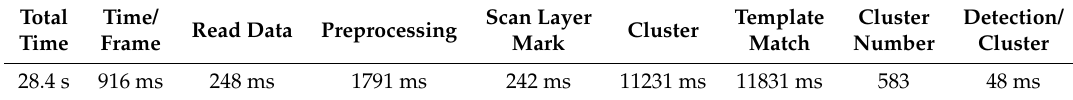
Table 4. Operation time of the pedestrian